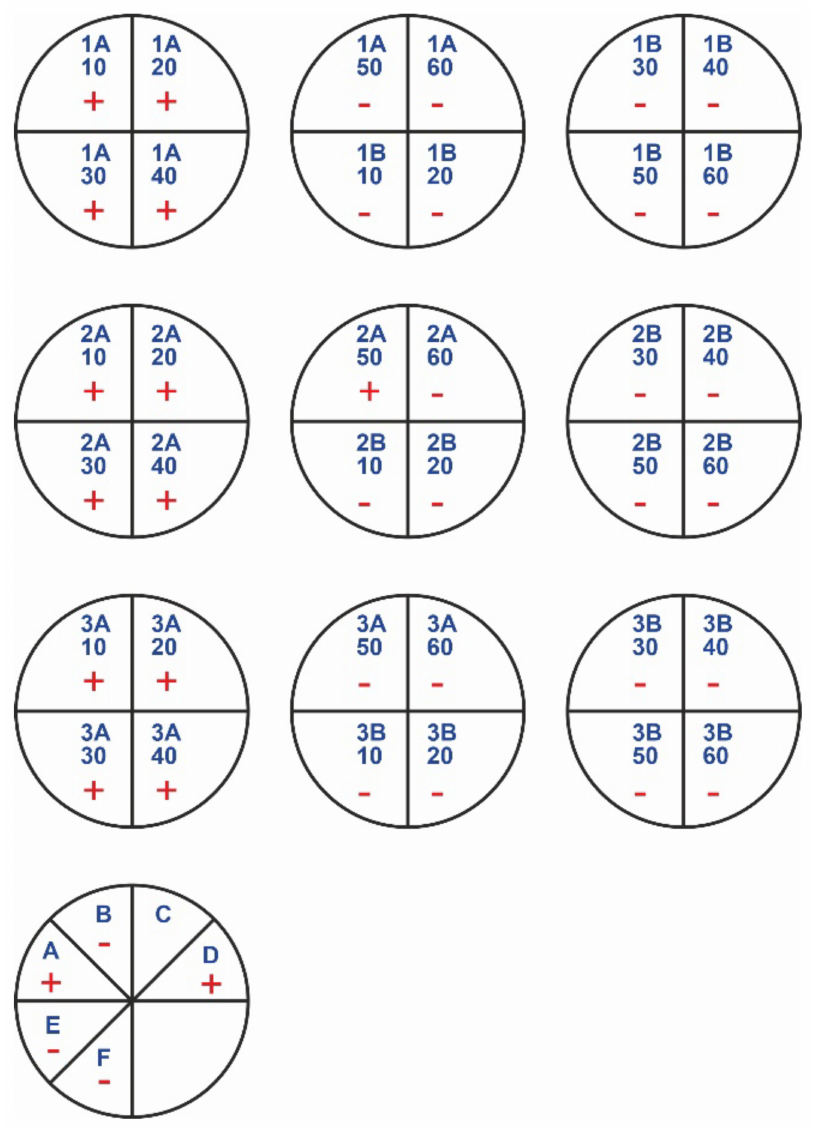
Figure 2. Growth of bacteria in medium